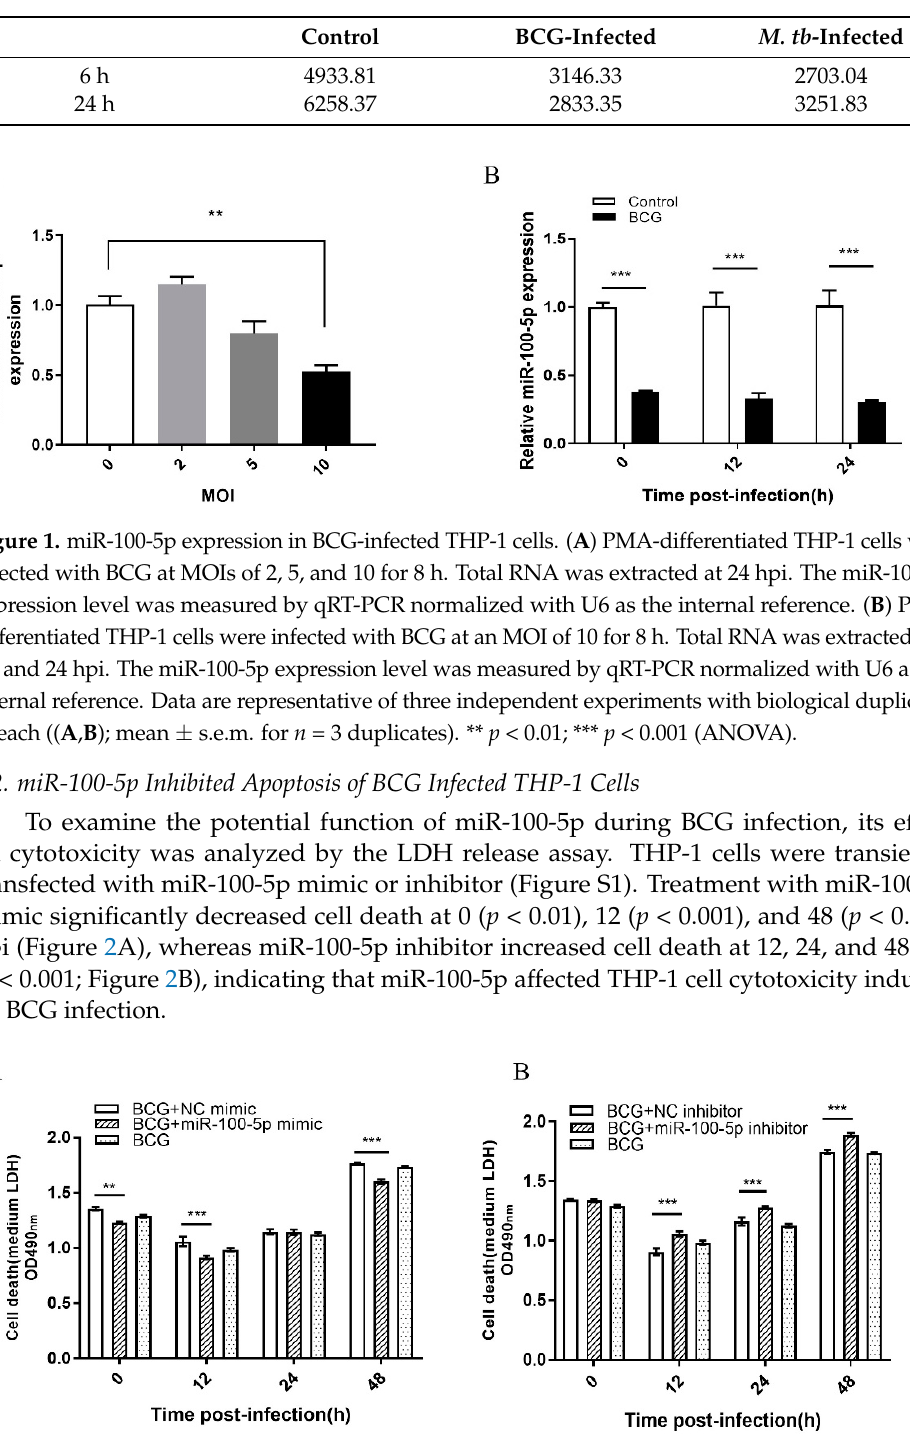
Table 2. TPM value of miR-100-5p expression in RNA-seq results.